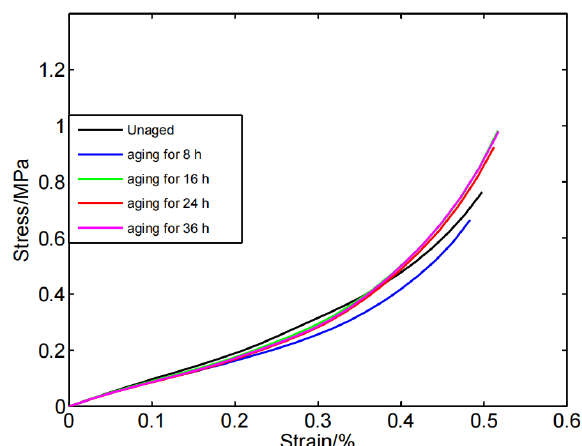
Figure 3. The stress–strain curves for silicone foam aged in the early stage.